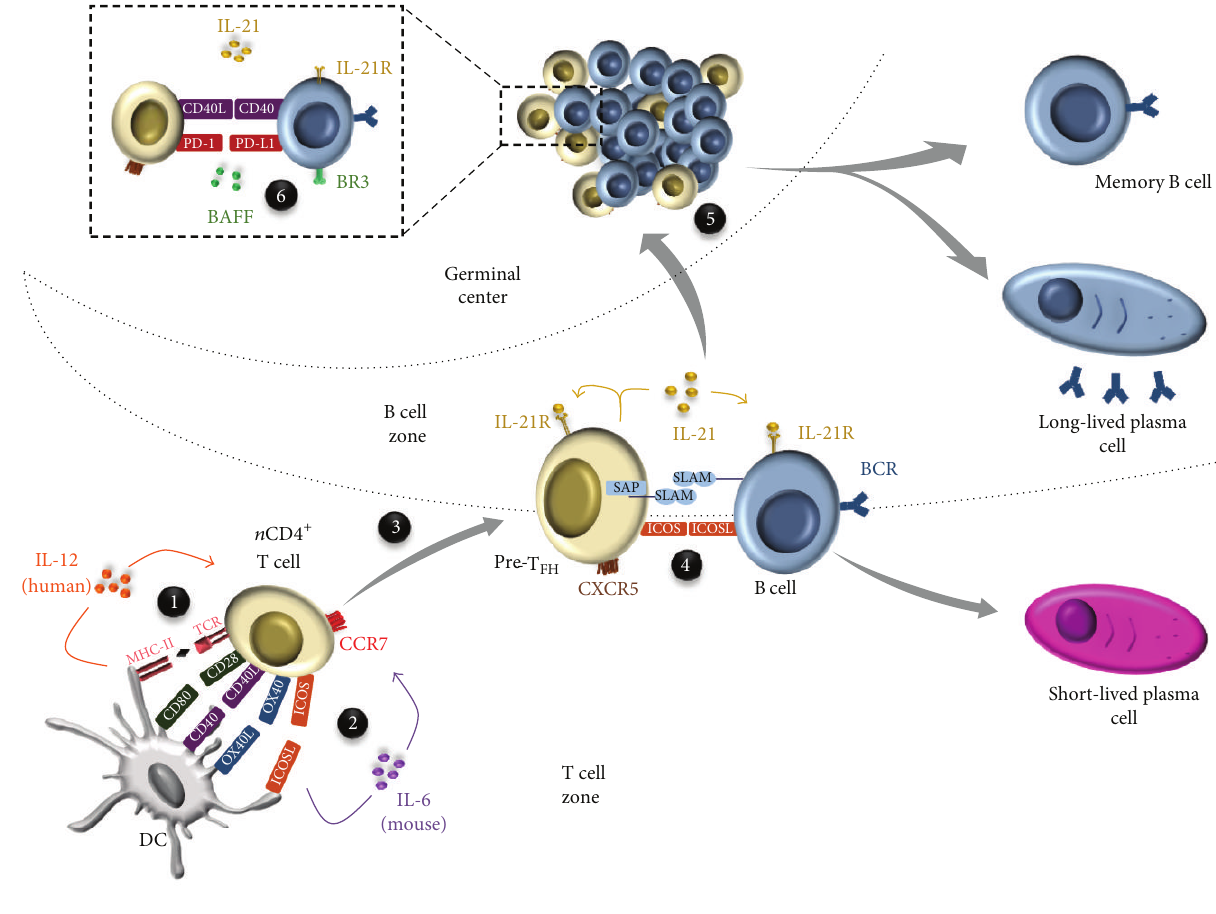
Figure 1: T differentiation in secondary lymphoid organs is a multistep process required to establish a high affinity antibody response. FH (1) Naive CD4 + T cells localized in the T cell zone are first primed by DC thanks to MHCII-peptide-TCR interactions. (2) Once activated, CD4 + T cells upregulate costimulatory molecules such as CD40L, OX40, and ICOS, favoring their crosstalk with DC. Combined with this cells. (3) Thanks interaction DC-derived cytokines (IL-6 in mice and IL-12 in humans) drive differentiation of activated T cell into pre-T FH cells are attracted to the T-B border by a CXCL13 gradient. (4) A SAP/SLAM- to CXCR5 upregulation and CCR7 downregulation, pre-T FH cells occurs at the T-B border, finalizing T cell differentiation. (5) stabilized interaction between ICOSL-expressing B cells and pre-T FH FH cells migrate toward the GC, where they provide help to B cells. This crosstalk induces both B cell differentiation in plasma Finally, mature T FH cells and memory B cells, thanks to IL-21/IL-21R and CD40/CD40L signals, and B cell survival via BAFF/BR3 and PD1/PD-L1 interactions